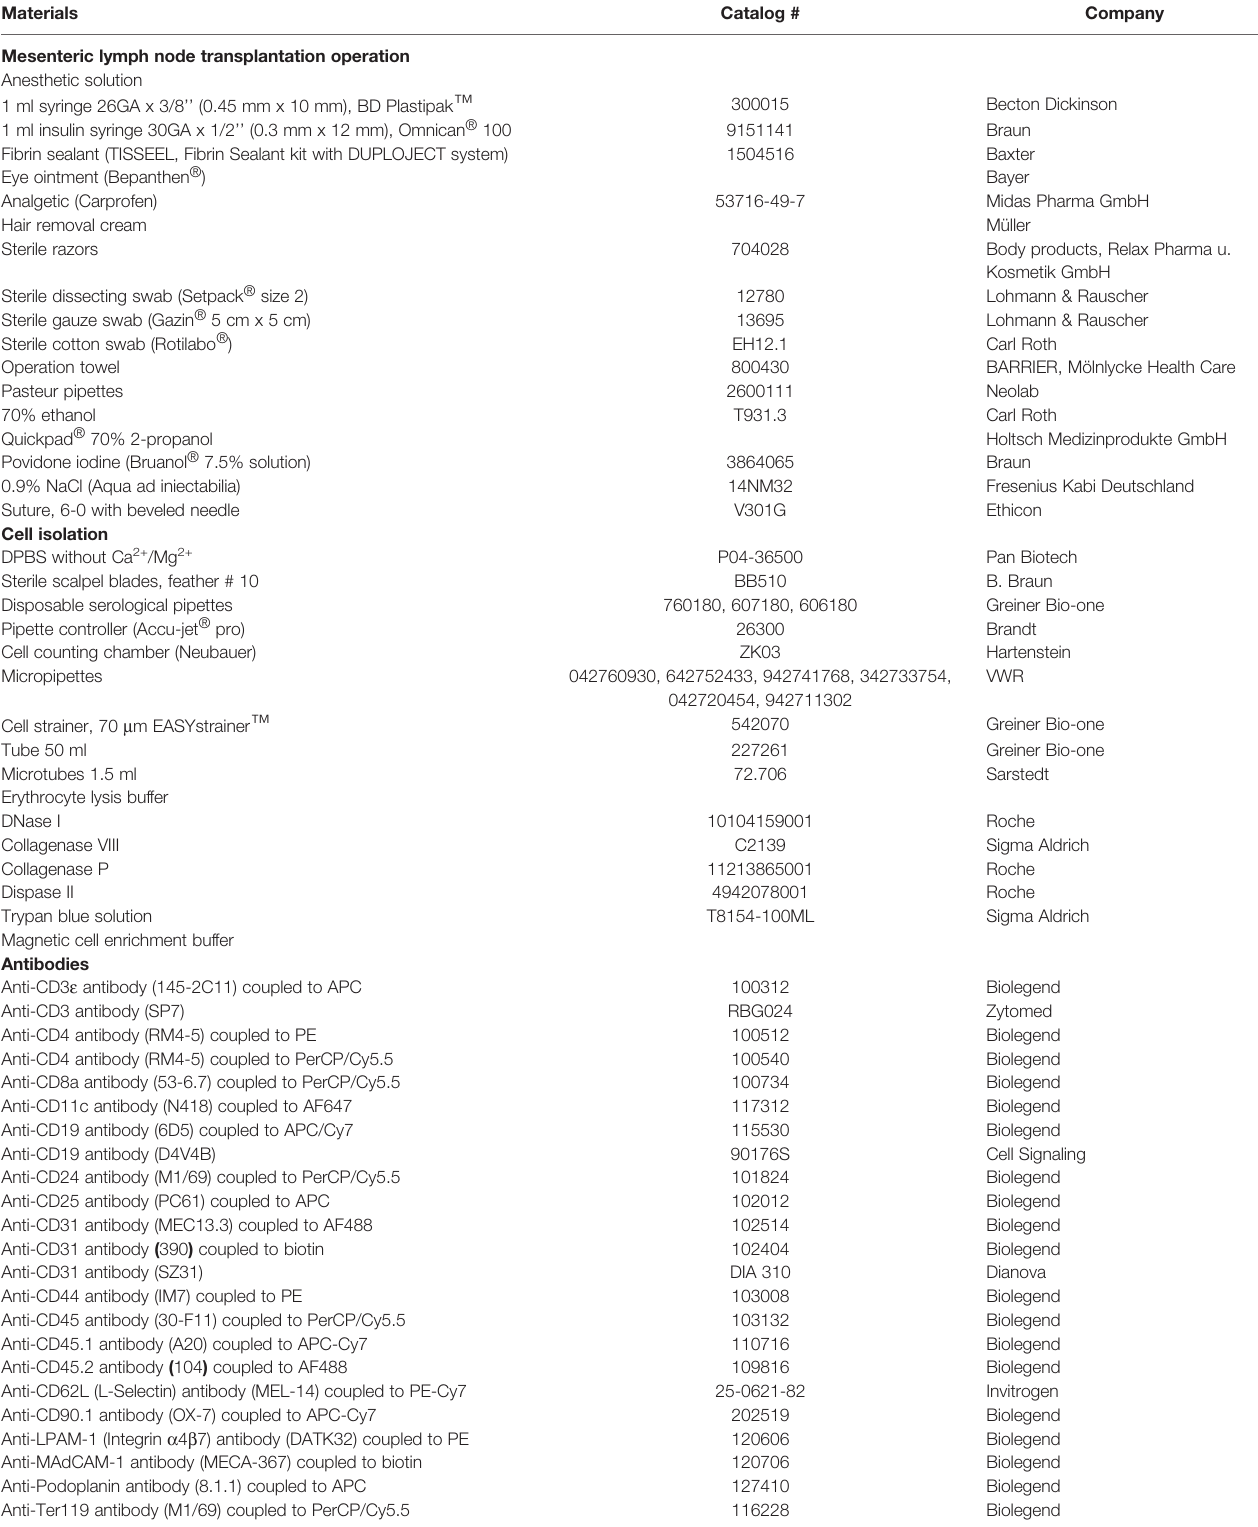
TABLE 1 | Materials used for the LN transplantation and associated techniques.